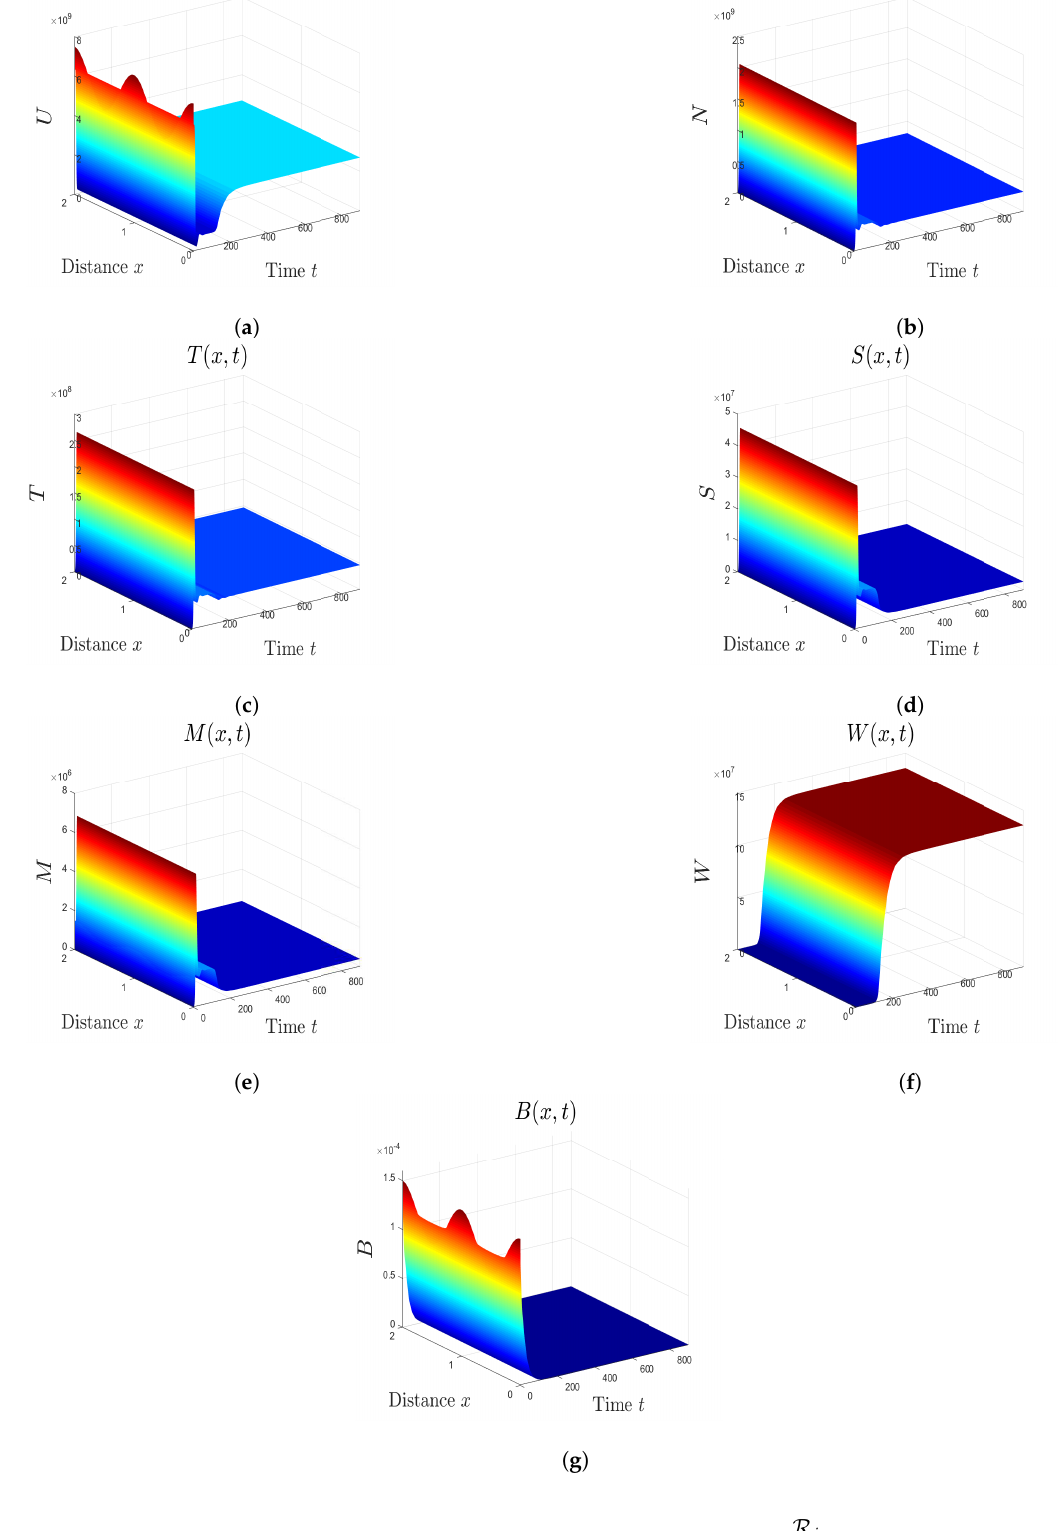
Figure 4. The numerical simulations of model (3) when R k > 1 and equilibrium E 3 is globally asymptotically stable. The subfigures show the spatiotemporal behaviors of ( a ) uninfected red blood cells U , ( b ) ring infected red blood cells N , ( c ) trophozoite infected red blood cells T , ( d ) schizont infected red blood cells S , ( e ) free merozoites M , ( f ) CTLs W , and ( g ) antibodies B